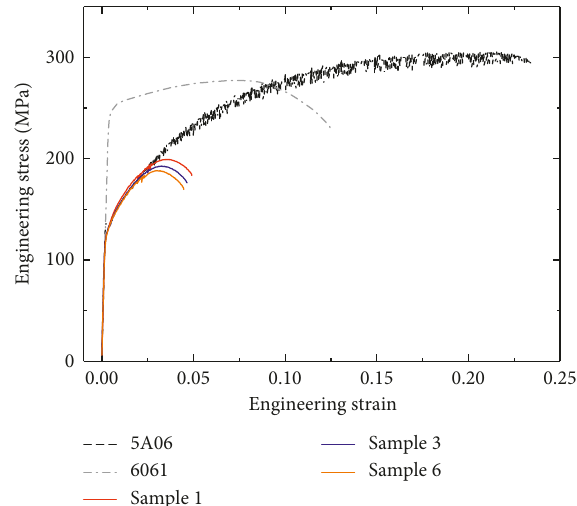
Figure 2: Engineering stress-strain curves of the FSW AA 6061-AA 5A06 specimens as compared to those of base metals AA 6061 and AA